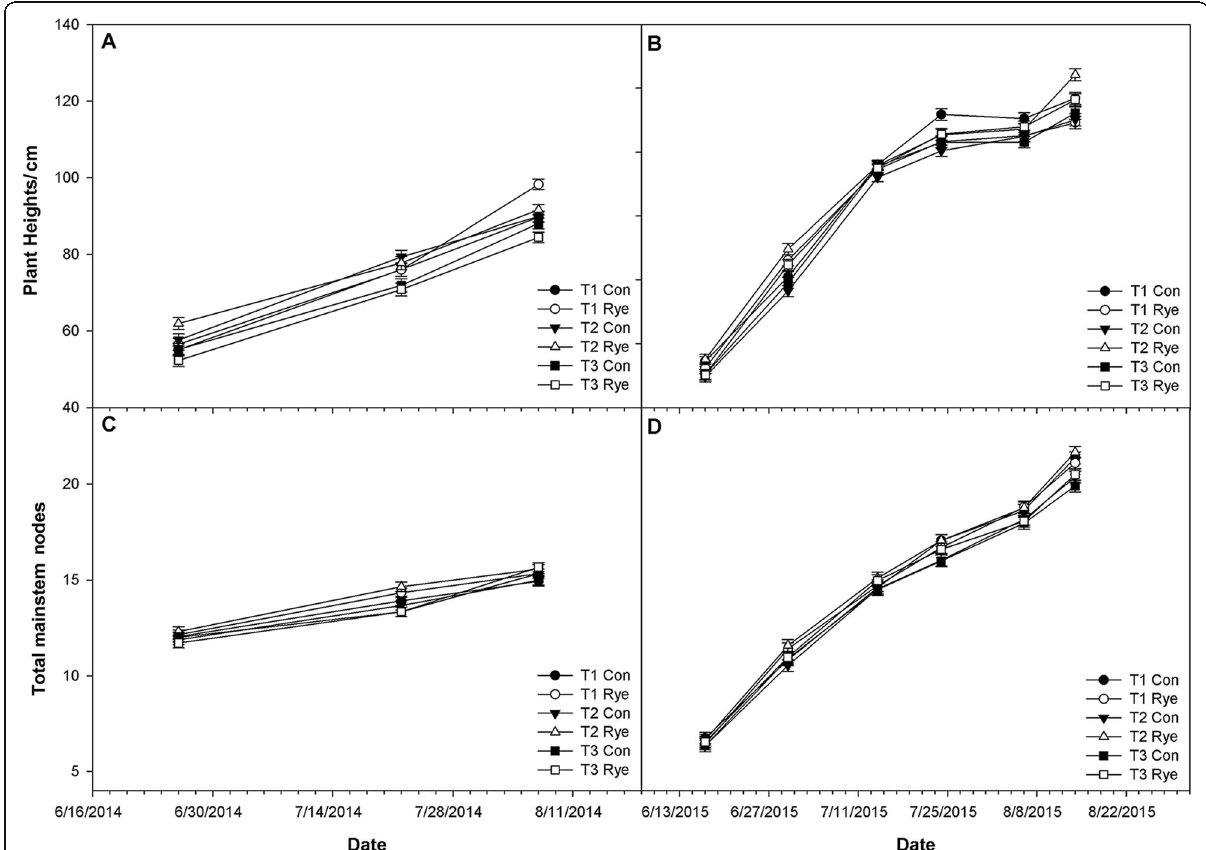
Fig. 3 Plant height and total mainstem nodes for cotton grown under irrigation regimes T1-T3 and planted into either conventionally tilled beds (Con) or a heavy rye cover crop residue (Rye) during the 2014 ( a , c ) and 2015 ( b , d ) growing seasons at a field site near Tifton, GA. Values are means ± standard error ( n =